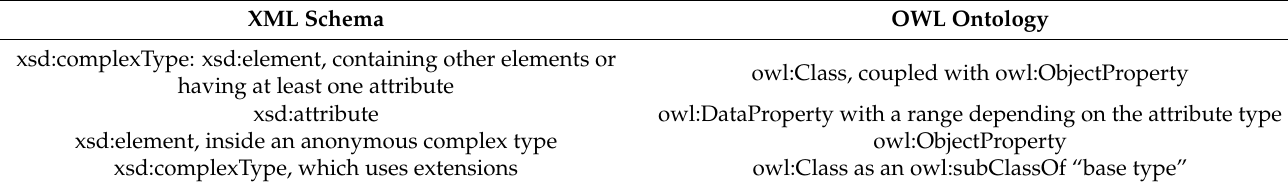
Table 3. XML schema to OWL ontology mapping